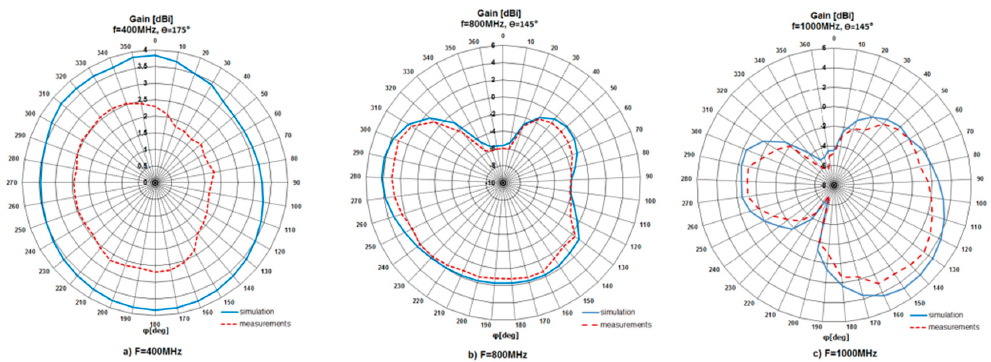
Figure 6. Simulated and measured radiation pattern in horizontal plane for different frequencies.